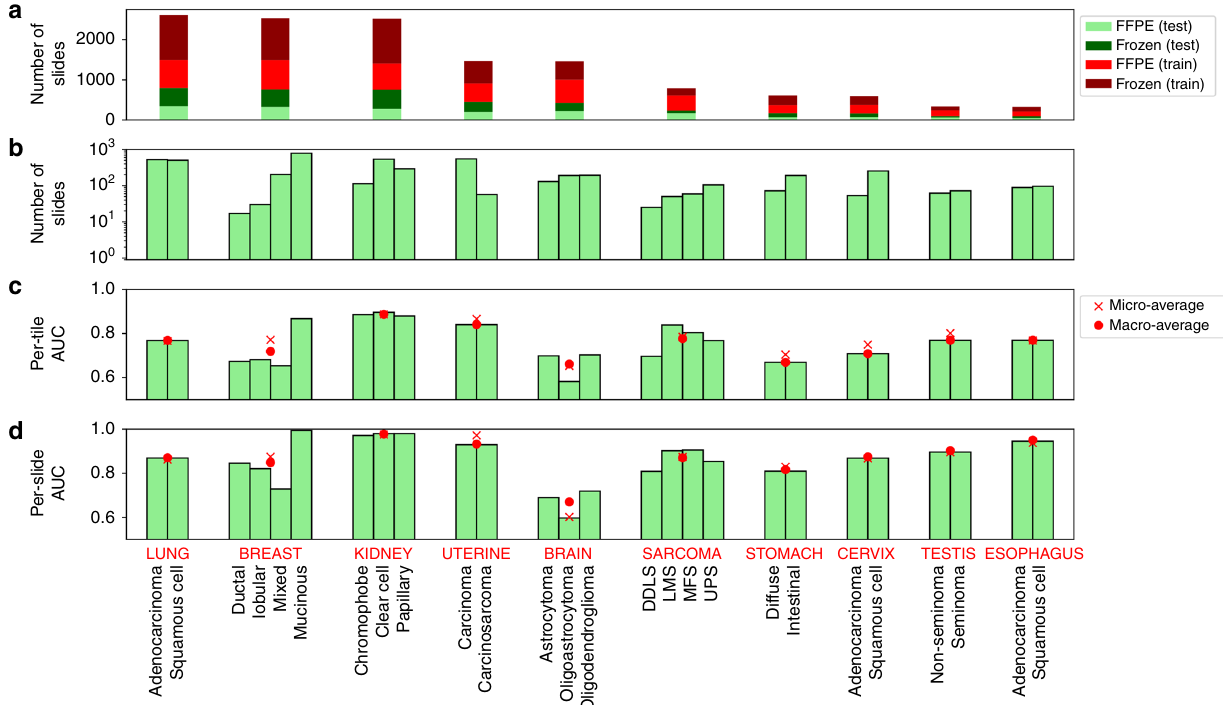
Fig. 3 Subtype classi fi cation using CNNs. a The number of samples used for training. b The number of samples for each subtype. c AUC ROC for subtype classi fi cations at the tile level ( d ) and at the slide